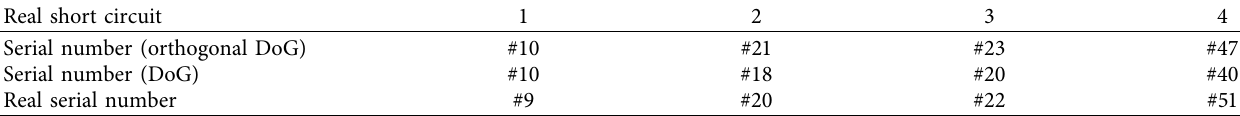
Table 3: Serial numbers of the four short circuits determined by the orthogonal DoG filter and the DoG filter.